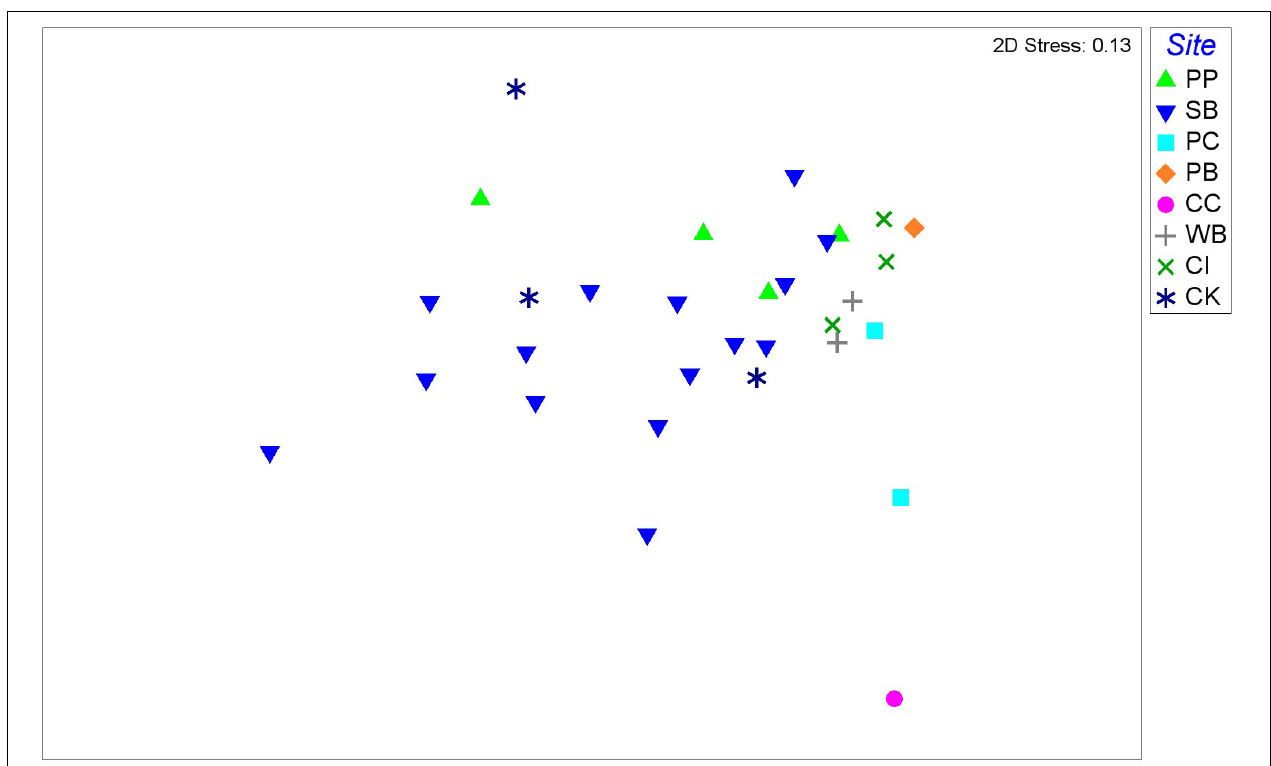
FIGURE 6 | Non-metric multidimensional scaling plot of microbial communities associated with the sponge M. acerata , with symbols representing different sites sampled along the WAP. The analysis is based on fourth root transformed relative abundances of microbial taxa. PC, Potter Cove; CC, Cierva Cove; WB, Wilhelmina Bay; CI, Cuverville Island; PB, Paradise Bay; SB, South Bay; PP, Py Point; CK, Cape